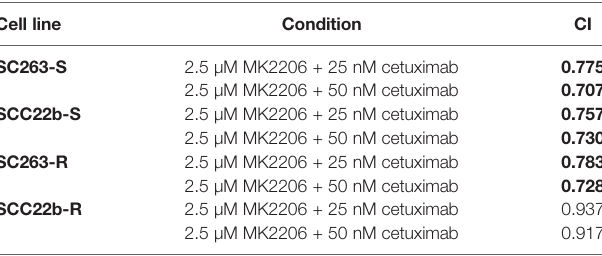
TABLE 2 | CI for HNSCC cell lines after treatment with cetuximab plus 2.5 µM MK2206 for 72h. Cell